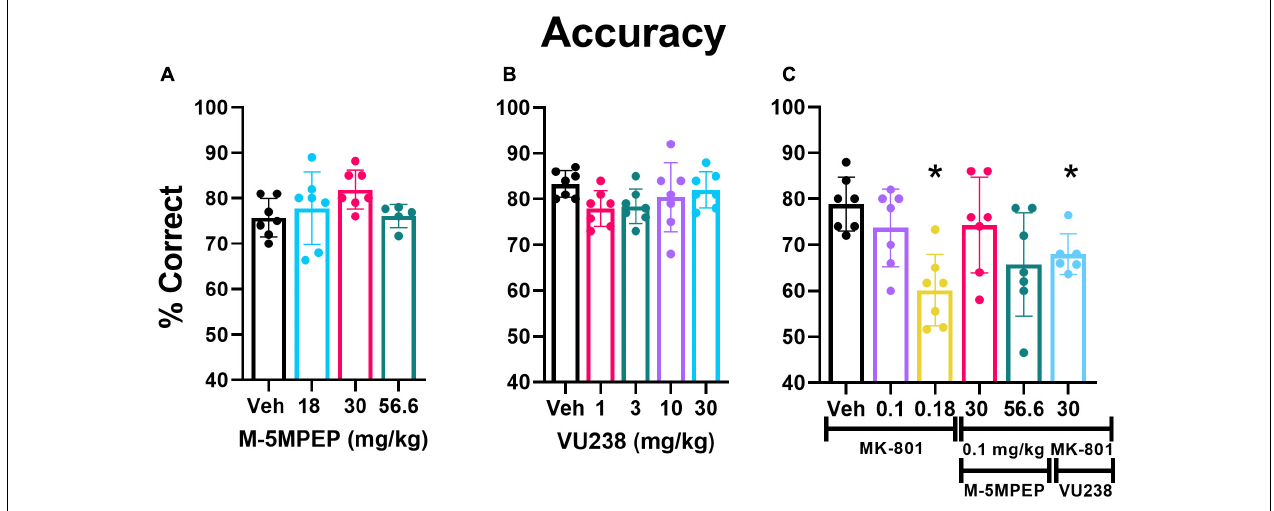
FIGURE 4 | VU0424238 in combination with MK-801, but neither compound alone, disrupted accuracy on the PAL task. Bars depict group data as mean ( ± SEM) and circles within/above each bar depict individual data are shown for percent accuracy on the PAL task. M-5MPEP (A) and VU0424238 (VU238) (B) did not alter % accuracy on the PAL task. MK-801 alone dose-dependently decreased accuracy, and VU0424238 in combination with 0.1 mg/kg MK-801 (C) decreased accuracy. * p < 0.05 compared to vehicle-treated